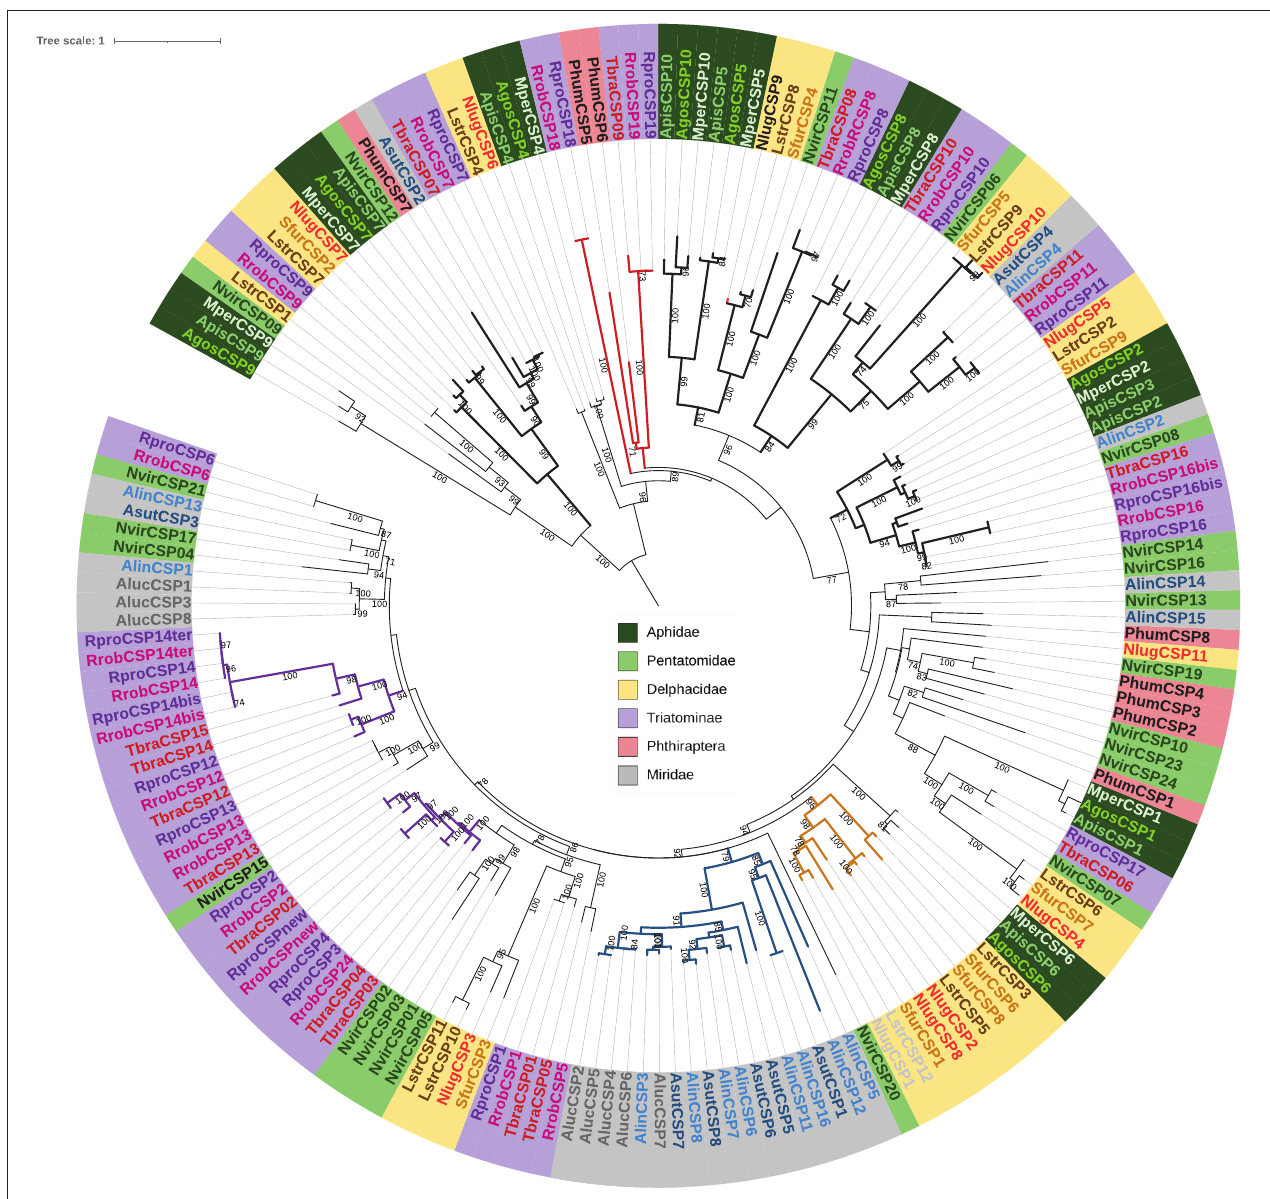
FIGURE 2 | Maximum likelihood phylogenetic tree of CSPs. Hemiptera species: Triatominae: Rhodnius prolixus (Rpro), Rodnius robustus (Rrob), Triatoma brasiliensis (Tbra), Aphidae Myzus persicae (Mper), Aphis gossypii (Agos), and Acyrthosiphon pisum (Apis); Miridae: Adelphocoris suturalis (Asut), Apolygus lucorum (Aluc), and Adelphocoris lineolatus (Alin); Delphacidae: Nilaparvata lugens (Nlug), Laodelphax striatellus (Lstr), and Sogatella furcifera (Sfur), and one Pentatomidae: Nezara viridula (Nvir); and Phthiraptera: Pediculus humanus (Phum). The four dark clades in bold indicate generalist CSP clades while the red clade indicate CSPs from the hematophagous species. The other colorated clades indicate CSP expansions, in purple for Triatominae, in blue for Miridae, in brown for Delphacidae. A bootstrap > 70% is indicated on the node. CSP sequences are given in Supplementary Table 1